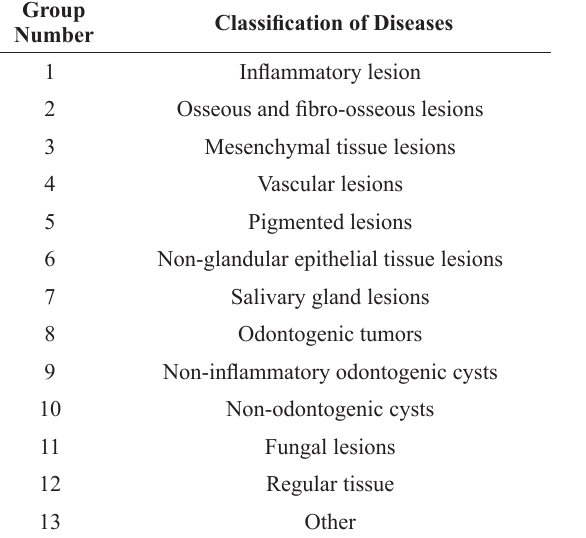
Grouping of diseases identified in the records of anatomopathological examinations.